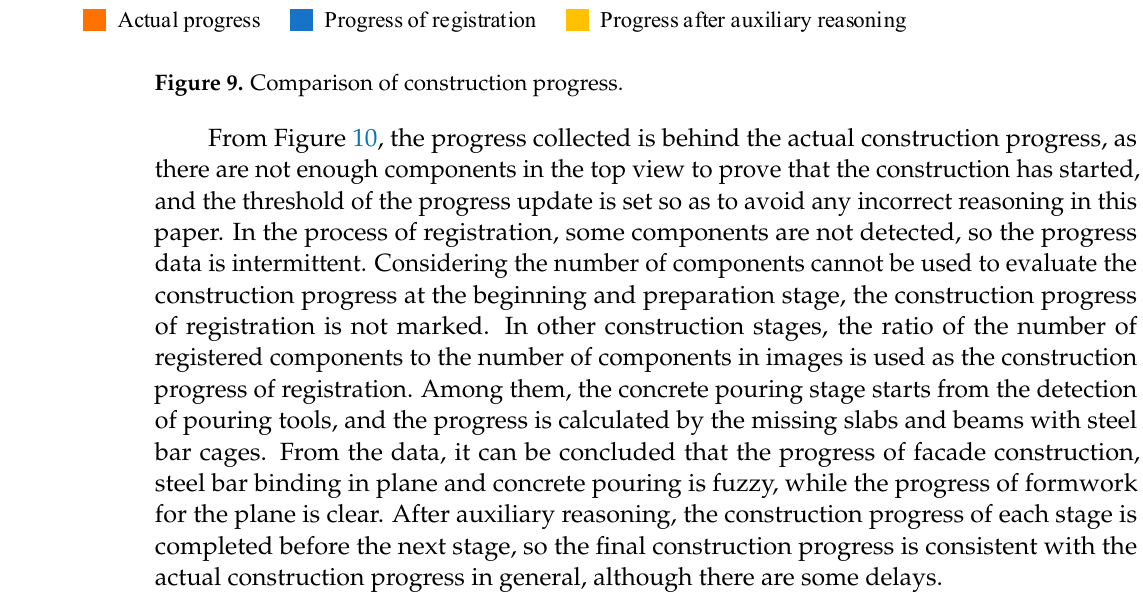
( c ) Figure 11. Registration error cases: ( a ) The interference of messy lines after rain; ( b ) Incomplete formwork; ( c ) Difficult distinction between stacked formwork and bottom formwork. The reason of reasoning error lies in two aspects: one is that some components cannot be detected, and the other is that the threshold to determine that the progress has changed is set. Among them, the setting of threshold is the necessary cost to avoid more serious errors. Figure 12 shows two examples of reasoning errors. No member is identified in Figure 12a, so it is assumed that the construction has entered the concrete curing stage, although the opposite is true. In Figure 12b, two bottom formworks are detected, however since the number is less than three, it is not determined that the construction has entered the plane formwork support stage.